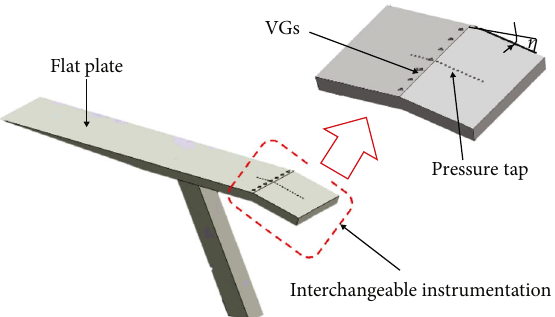
Figure 1: A sketch of the test con fi guration.